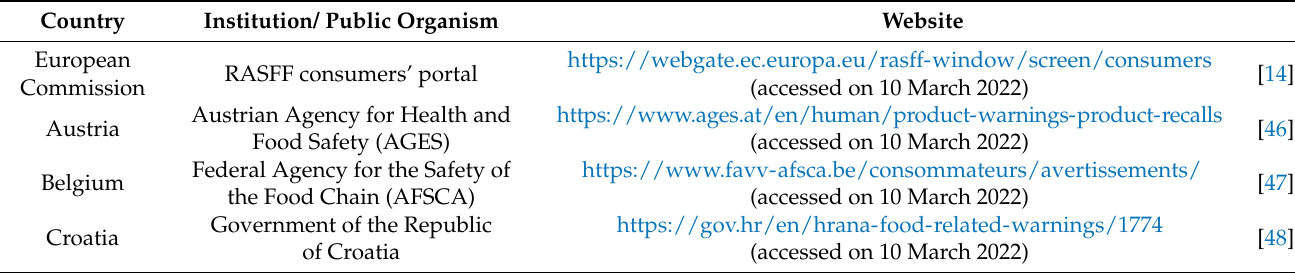
Table 6. Examples of institutional websites of European Union countries that provide practical undeclared allergen information (product recalls and other public health